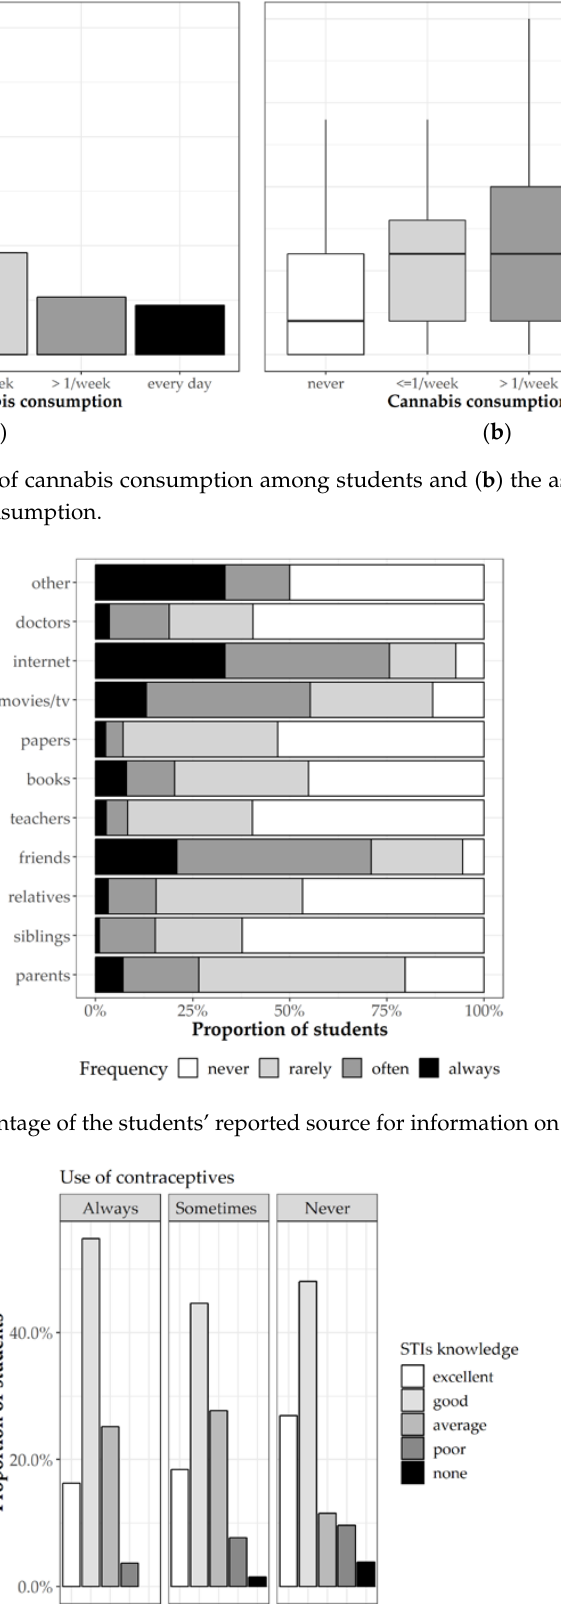
Figure 5. Perceived level of knowledge on STIs between students according to contraceptive use frequency.